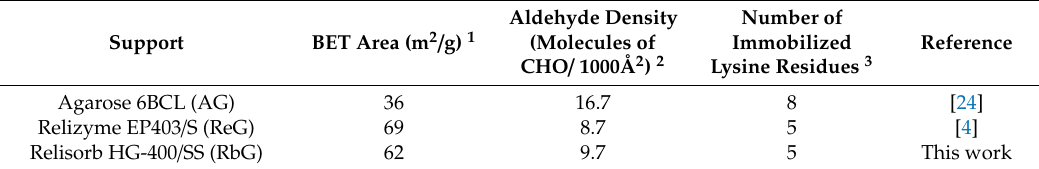
Table 1. Physical-chemical parameters of di ff erent immobilization